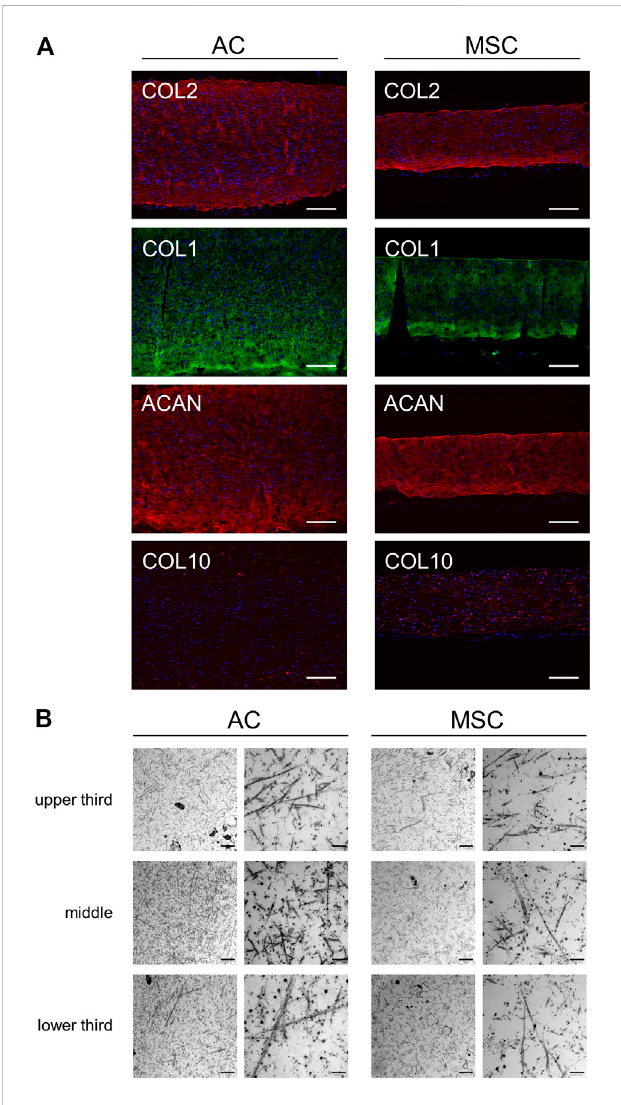
FIGURE 3 Microscopic analysis of disc sections. (A) Immuno fl uorescence analysis of stained cartilage discs after 4 weeks of differentiation. Sections of AC discs (left) and MSC discs (right) stained for COL2 (red), COL1 (green), ACAN (red) and COL10 (red). Nuclear staining with DAPI is presented in blue colour. Scale bar = 200 µm. One representative donor is shown per condition. (B) Transmission electron microscopy of cartilage discs after 4 weeks of differentiation. The presented TEM images from a frontal sample from the middle of the cartilage disc show differentsites(upper third, middle,lower third)ofthe matrix produced by ACs (left) and MSCs (right). Scale bar = 1 µm (left column for each disc type) and 200 nm (right